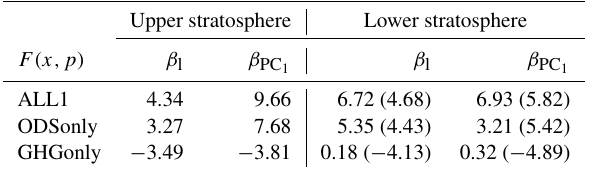
Table 2. Signal-to-noise ratios for the longest L -year analysis peri- ods shown in Figs. 7 and 8. Results are for the linear ( β l ) and nonlin- ear signal methods ( β PC ). For ODSonly and GHGonly, the longest 1 analysis period is 33 years (1984–2016). For ALL1, the longest analysis period is 31 years (1984–2014). The figures in brackets for the lower stratosphere indicate the signal-to-noise ratios when the tropics are excluded. Upper stratosphere Lower